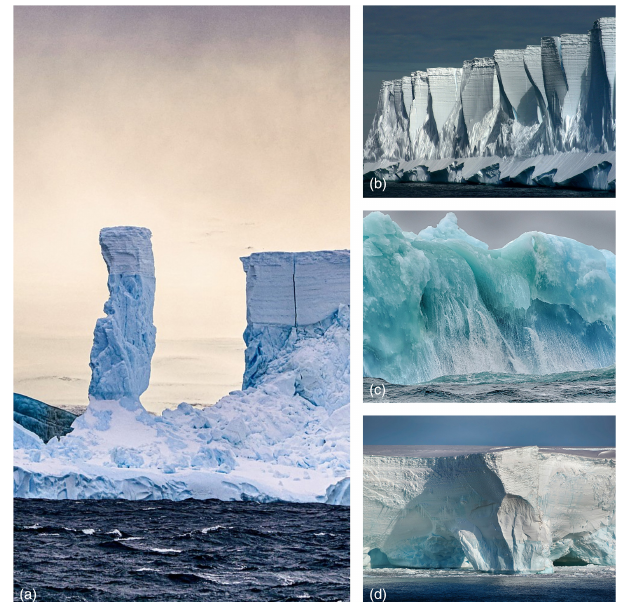
Figure 4. Icebergs in Antarctica. (a) Iceberg from XXI PNRA Antarctic expedition under the Western Antarctic Ice Sheet Evo- lution (WISE) project. (b, c) Sea ice view during shipping in the Ross Sea during the XXI PNRA Antarctic expedition under the WISE project. (d) Floating blue iceberg in the Ross Sea during the XXVIII PNRA expedition under the palaeomagnetism of sed- imentary cores from the Ross Sea outer shelf and continental slope (PNRA-ROSSLOPE II) project.